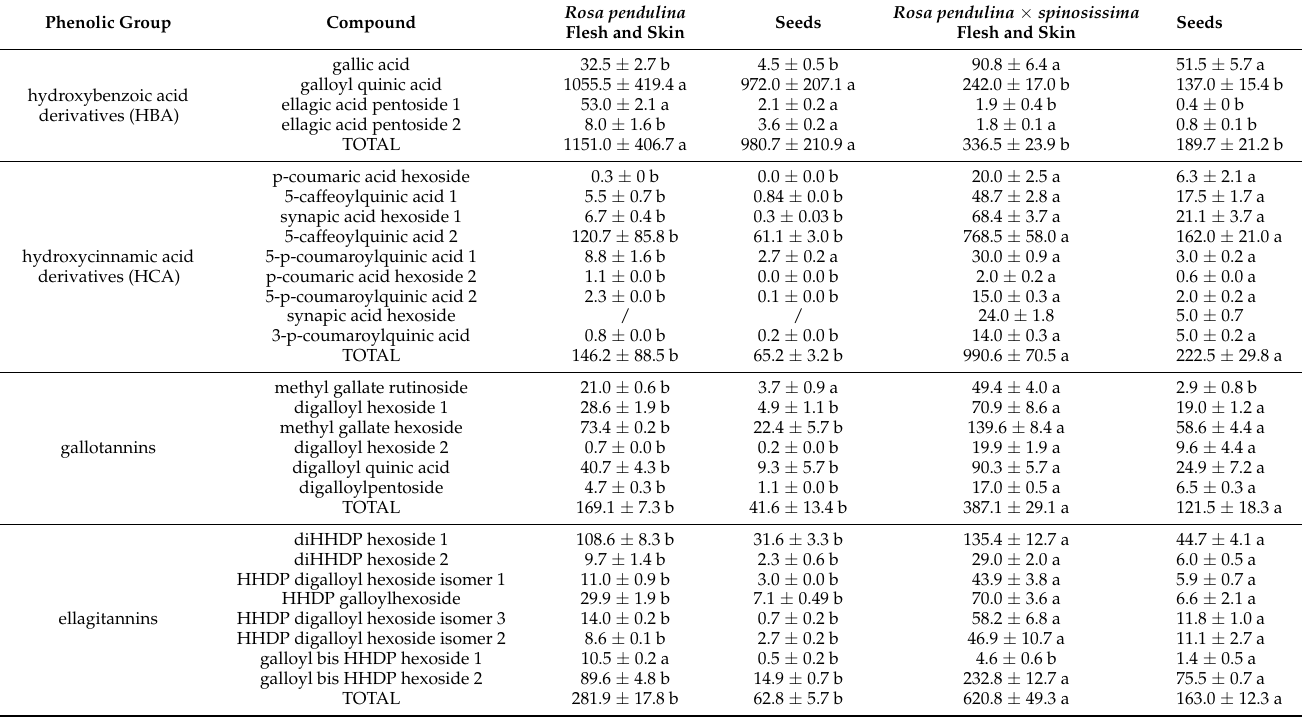
Table 2. The contents ± standard deviations (mg/kg FW) of phenolic compounds in hips of R. pen- dulina and the hybrid R. pendulina × spinosissima in the region of Western Slovenia in 2020. Different letters indicate statistical differences between the two genotypes, separately for flesh with skin and seeds.